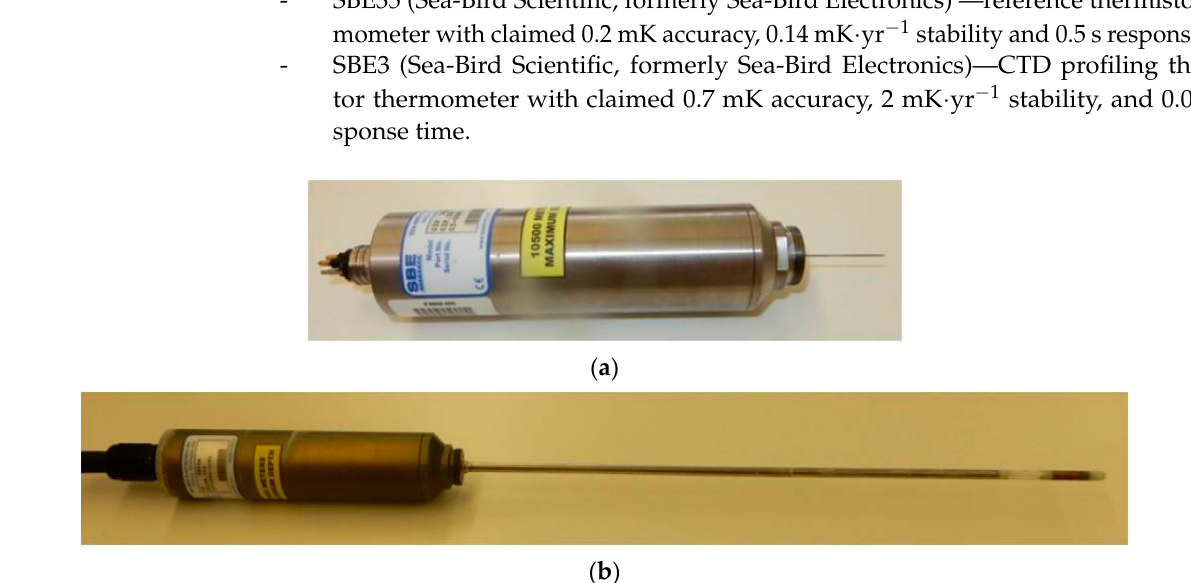
Figure 1. Deep-ocean thermometers from Sea-Bird Scientific—( a ) SBE3, needle length 56 mm and ( b ) SBE35, stem length 465 mm.